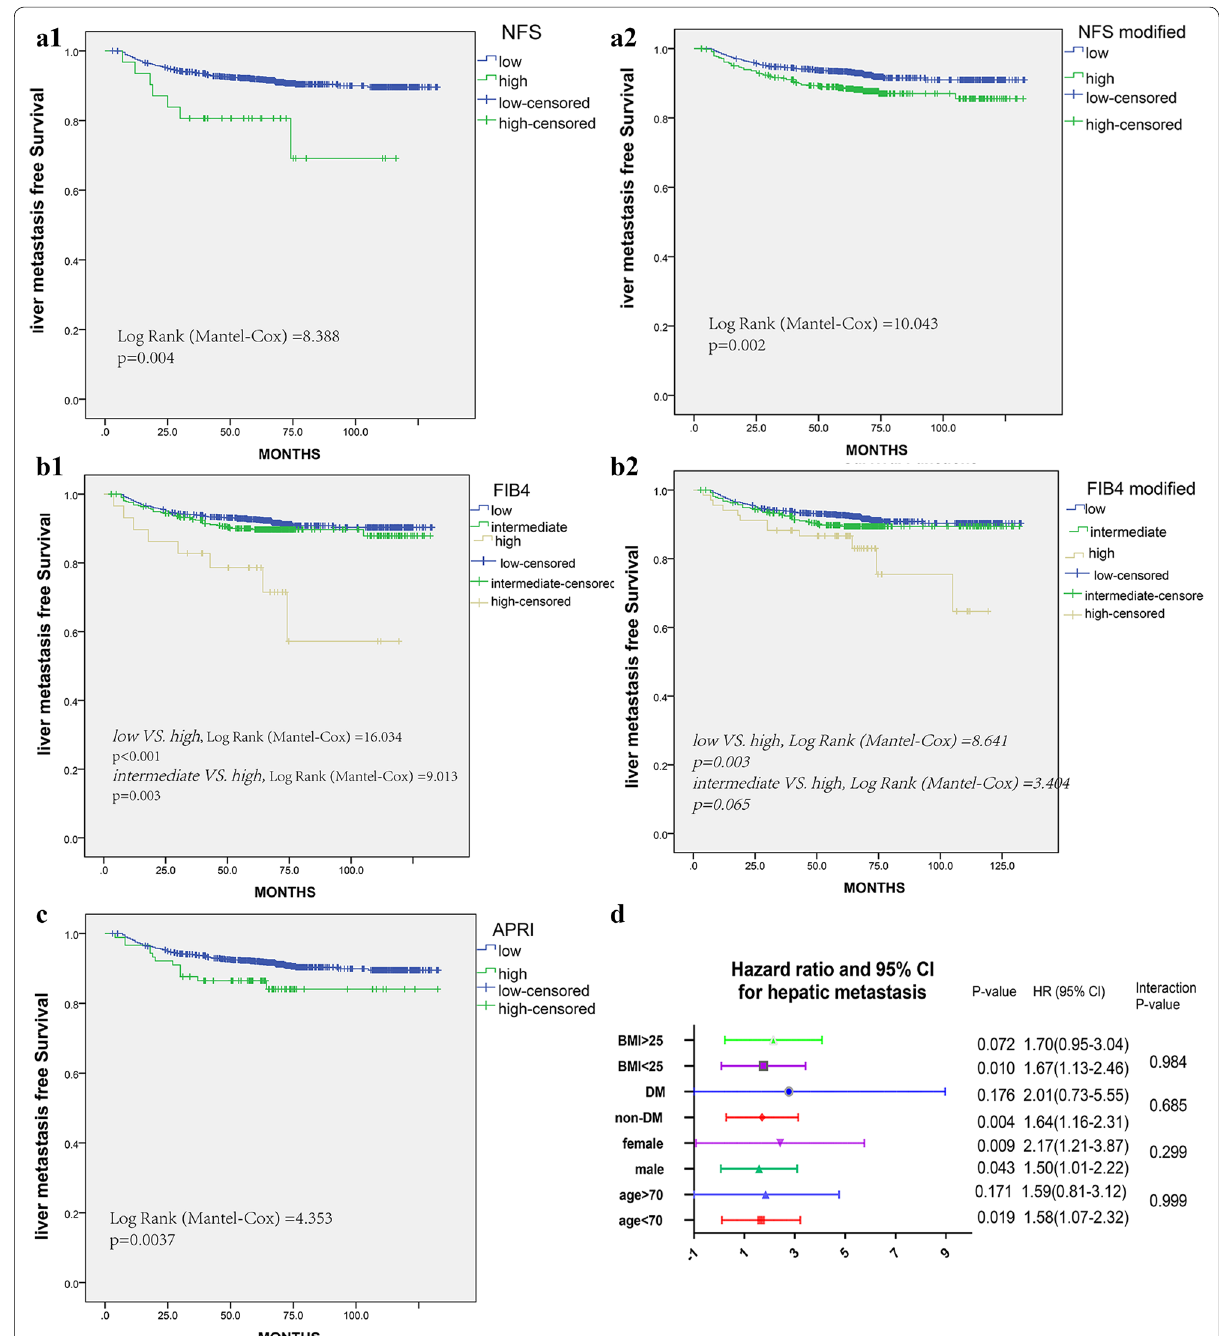
Fig. 1 Liver fibrosis score in NFS, FIB4, APRI measured by Kaplan–Meier survival for DFS in the discovery cohort. a1 original NFS score, b2 modified NFS score, b1 original FIB4 score, b2 modified FIB4 score; c APRI score; d Forest plot of the subgroup analysis showing no effect modification evident by age, gender, BMI, and